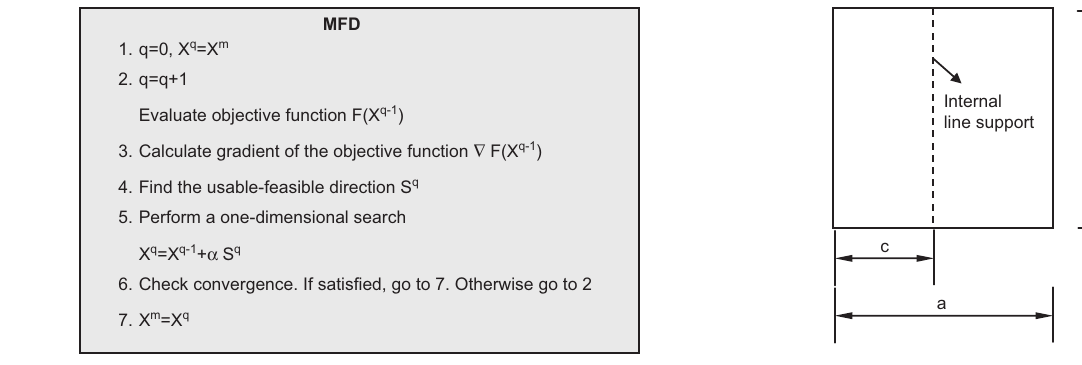
Figure 3 Plate with an internal line support.